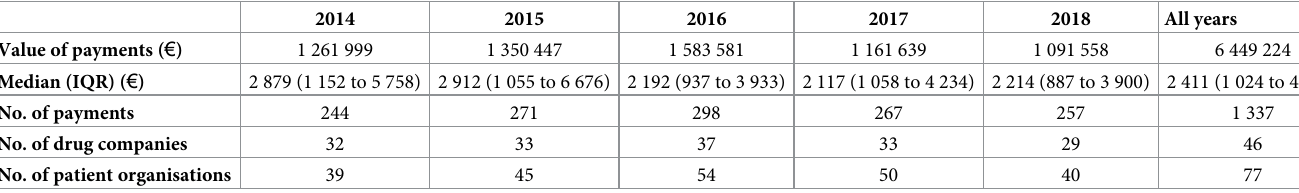
Table 1. Reported drug company payments to patient organisations in Sweden